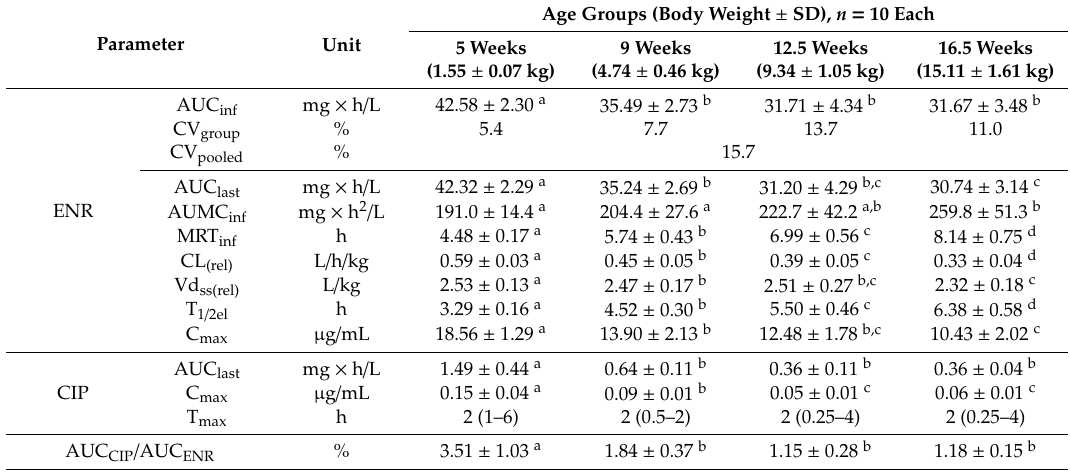
Table 1. Pharmacokinetic parameters after single intravenous enrofloxacin administration to turkeys dosed according to the protocol: Dose = 30 × BW 0.59 .